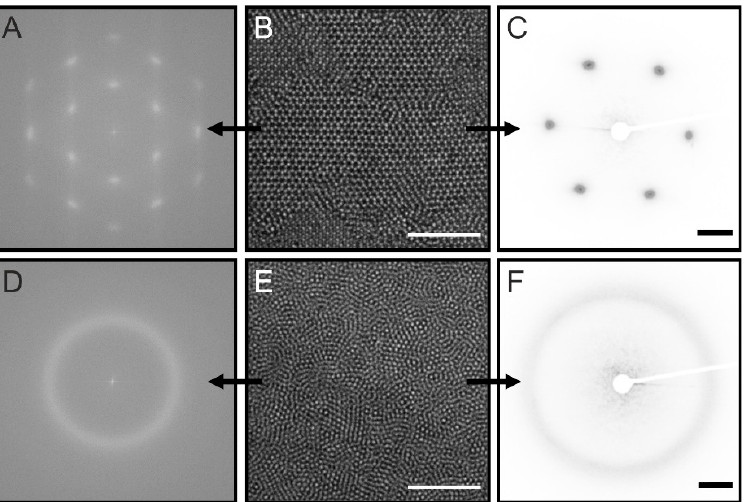
Figure 5. 3D colloidal microstructure analysis by CLSM and SALS ( A ) FFT calculated from a CLSM image of C 340 S 3.0 dispersed in NMP (naturally sedimented from a dilute sample) taken at approximately 58 μ m distance from the glass tube wall ( B ). ( C ) Corresponding diffraction pattern from SALS performed on the same sample as shown in ( B ). ( D – F ) the same set of data as in the top row for C 340 S 3.0 dispersed in NMP at a higher concentration taken at approximately 50 μ m distance from the glass tube wall ( E ). The scale bars correspond to 10 μ m in ( B , E ) and to 20 mm in ( C , F ).